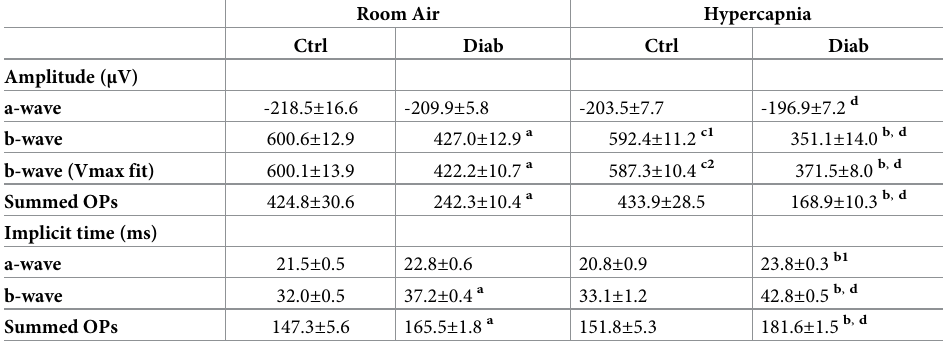
Table 2. ERG measures recorded in regular room air and in hypercapnia (mean ± SEM).